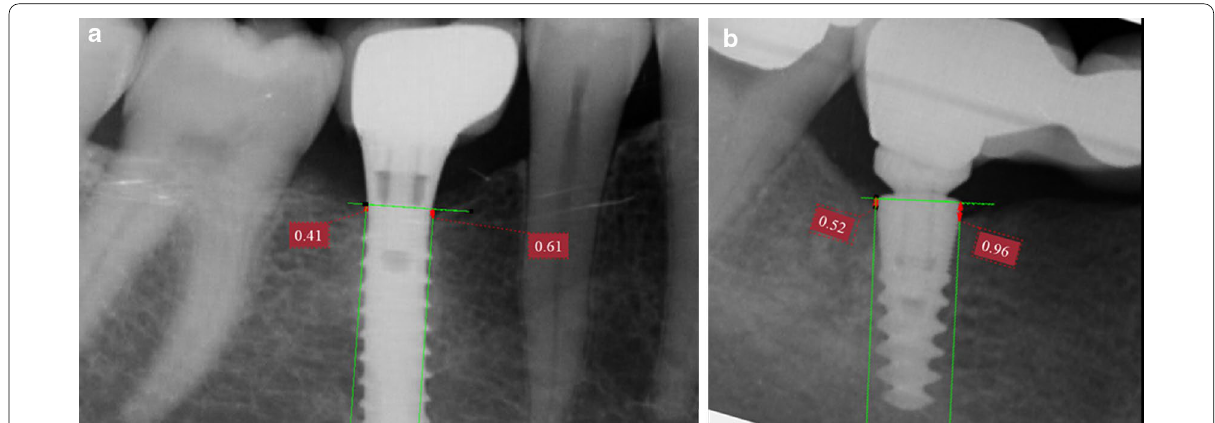
Fig. 3 Showing mesial and distal measurements of the first bone-to-implant contact, a tissue level implants and b bone level